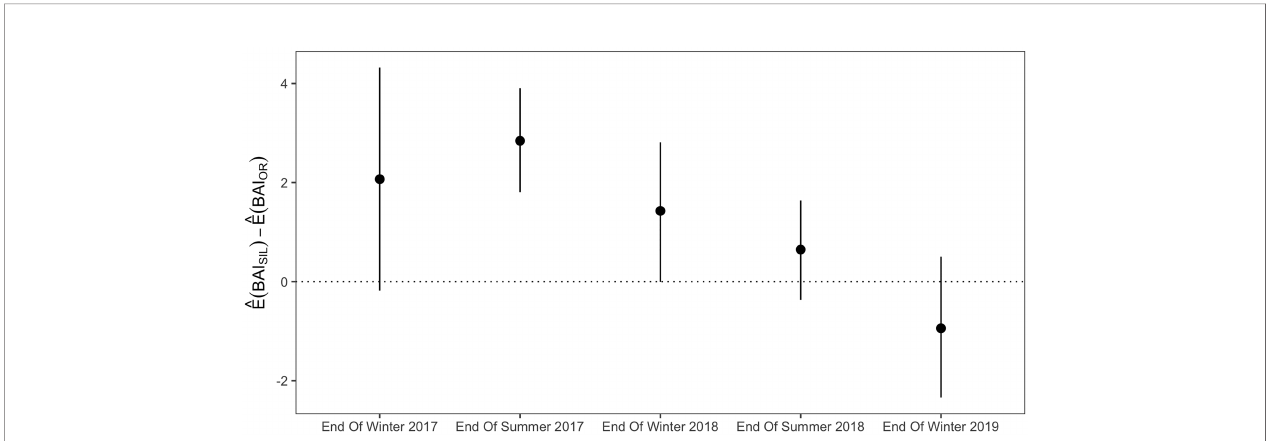
FIGURE 4 | Simultaneous Monte Carlo con fi dence intervals produced by the generalized linear hypothesis test of H 1 illustrating estimated differences between mean Body Area Index (BAI) by site (SIL – OR) within phenology groups. Points represent the mean estimated difference and vertical lines represent simultaneous Monte Carlo con fi dence